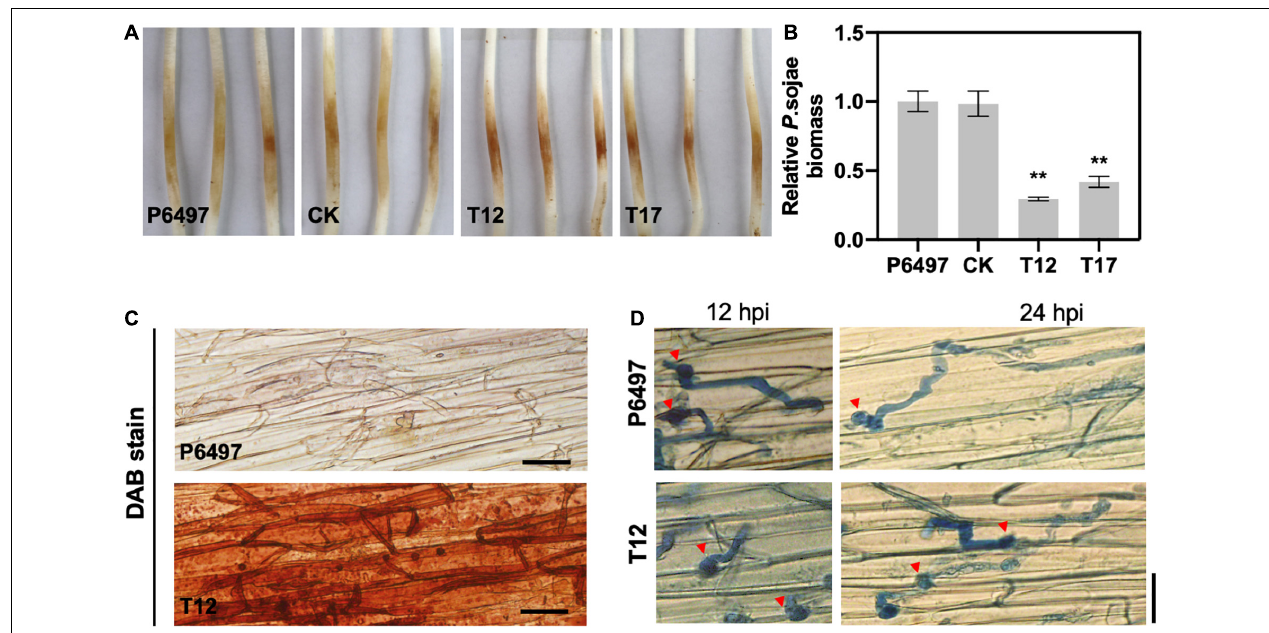
FIGURE 6 | The PsGRASP knockout mutants are impaired in virulence. (A) Lesions on soybean (cultivar Hefeng 47) etiolated hypocotyls at 48 hours post-inoculation (hpi) of P6497, CK, T12, or T17 zoospores. Experiments were repeated three times with similar results. (B) Relative pathogen biomass in inoculated etiolated hypocotyls, which is expressed as the ratio between the amounts of P. sojae and soybean DNA detected at 48 hpi. The ratio of P6497/soybean was set at 1.0. Error bars denote SD. ** P < 0.01, Student’s t -test. (C) DAB staining of the hypocotyls epidermis infected by P6497 and T12. (D) Microscopic observations of invasive hyphae in the epidermis of soybean hypocotyls at 24 hpi. Trypan Blue staining was performed on the epidermis of seedling hypocotyls. Red arrowheads indicate cysts. Bar, 20 µ m.